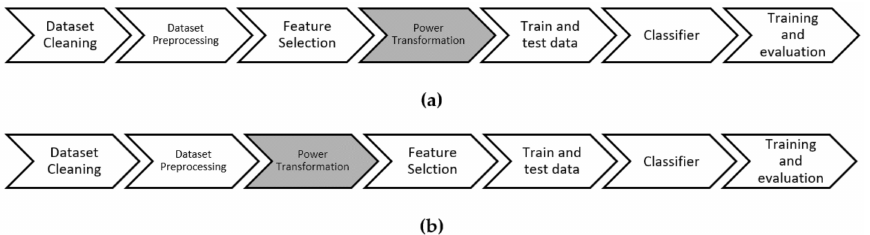
Figure 2. Experimental flow: ( a ) traditional flow; ( b ) proposed